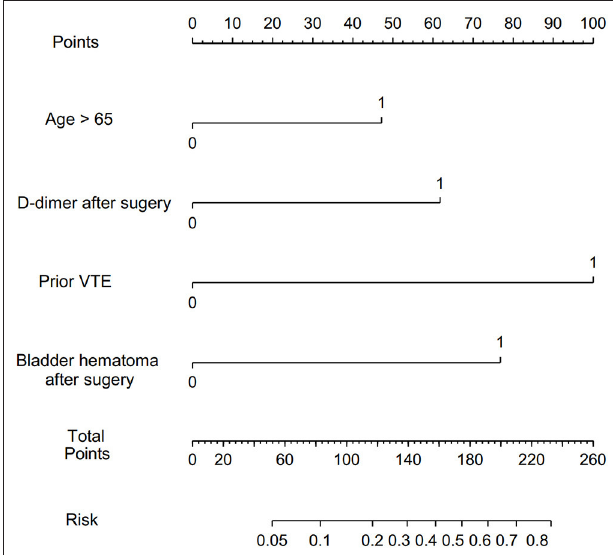
FIGURE 1 | Nomogram to predict the probability of VTE after TURP. VTE, venous thromboembolism; TURP, transurethral resection of the prostate.